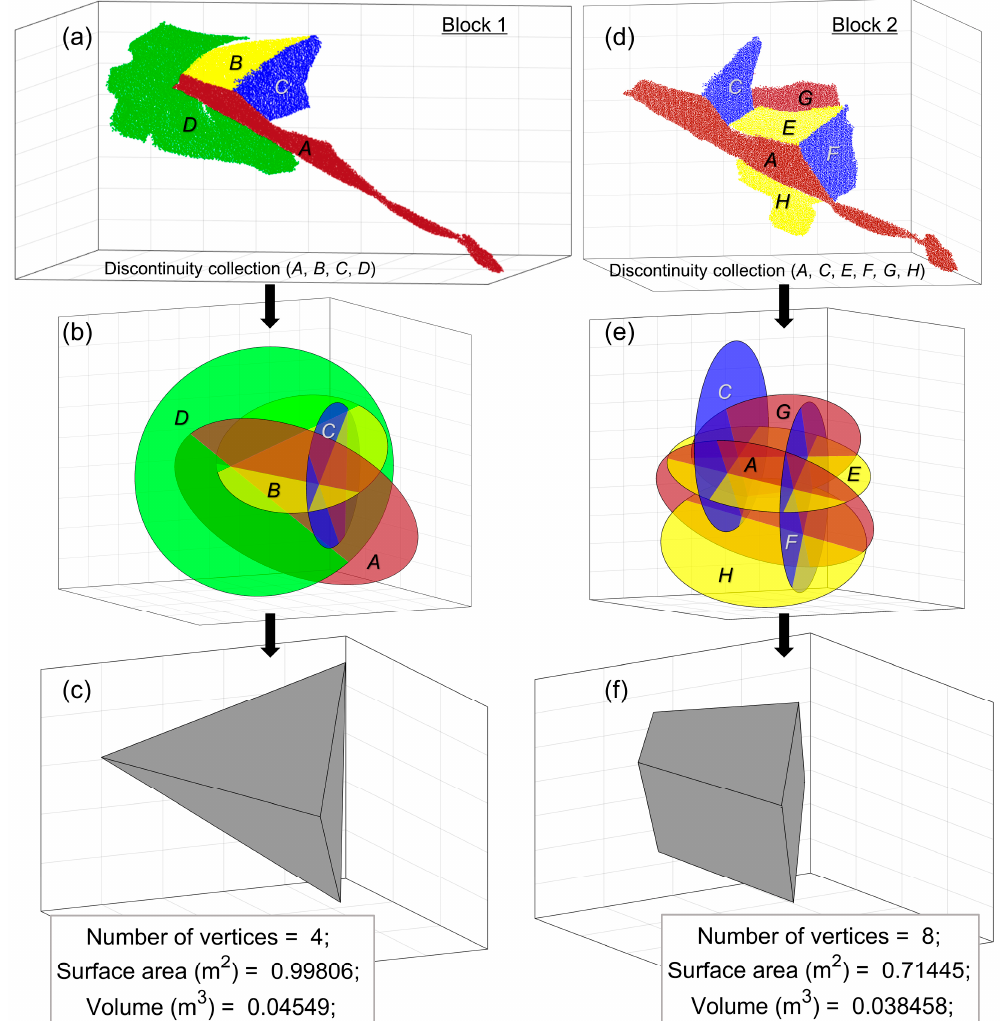
Figure 7. The discontinuity collections of Blocks 1 ( a ) and 2 ( d ), the polyhedral modeling based on extension of existing discontinuity planes of Blocks 1 ( b ) and 2 ( e ), and the final block model and calculated parameters for Blocks 1 ( c ) and 2 ( f ).